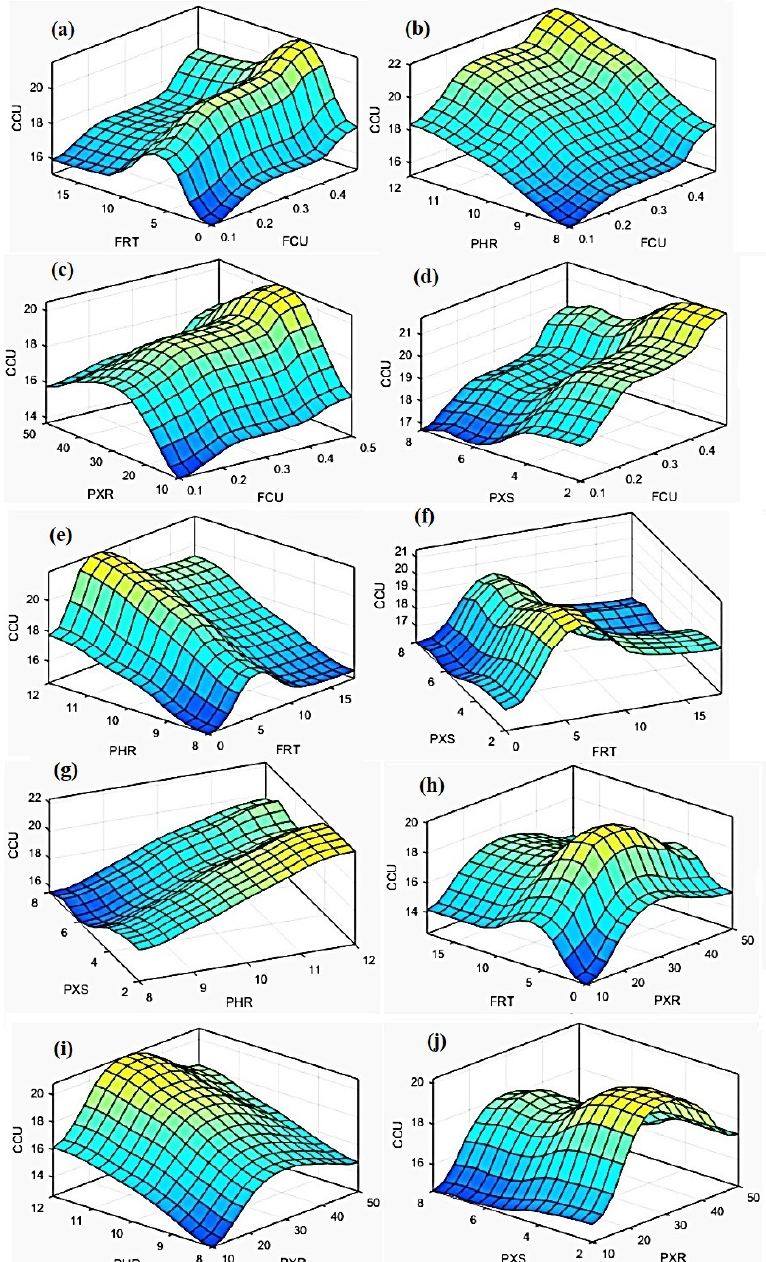
Figure 10. Resulting response surfaces of the PSM model—dependence of final concentrate quality (CCU) on input parameters. ( a ) copper content in the feed (FCU) and frother consumption (FRT); ( b ) copper content in the feed (FCU) and pH value of slurry at rougher flotation circuit (PHR); ( c ) copper content in the feed (FCU) and collector consumption at rougher flotation circuit (PXR); ( d ) copper content in the feed (FCU) and collector consumption at scavenger flotation ciruit (PXS); ( e ) frother consumption (FRT) and pH value of slurry at rougher flotation circuit (PHR); ( f ) frother consumption (FRT) and collector consumption at scavenger flotation ciruit (PXS); ( g ) pH value of slurry at rougher flotation circuit (PHR) and collector consumption at scavenger flotation ciruit (PXS); ( h ) frother consumption (FRT) and collector consumption at rougher flotation circuit (PXR); ( i ) pH value of slurry at rougher flotation circuit (PHR) and collector consumption at rougher flotation circuit (PXR); ( j ) collector consumption at scavenger flotation ciruit (PXS) and collector consumption at rougher flotation circuit